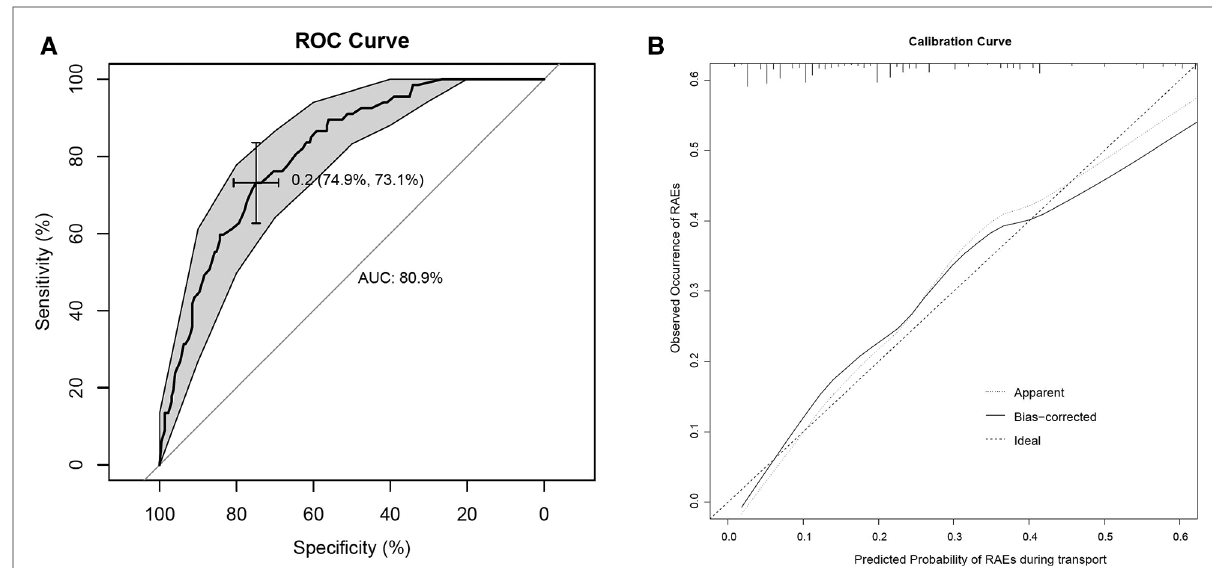
risk range of 0% – 74%.